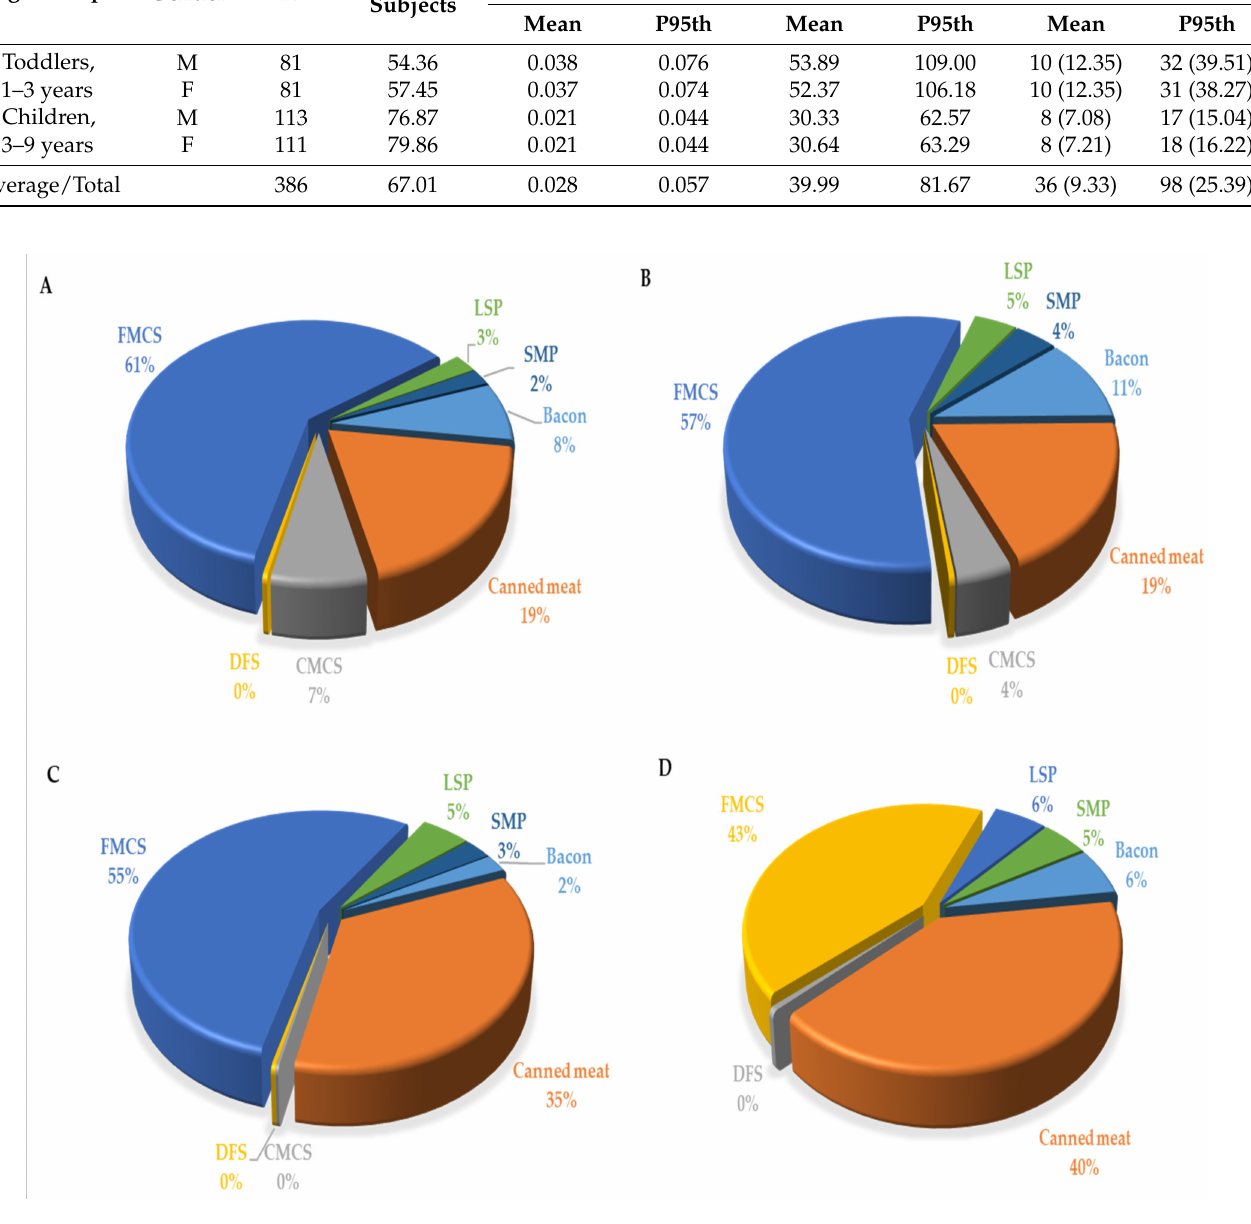
Figure 3. Contribution (%) of the most important food groups of processed meat products to